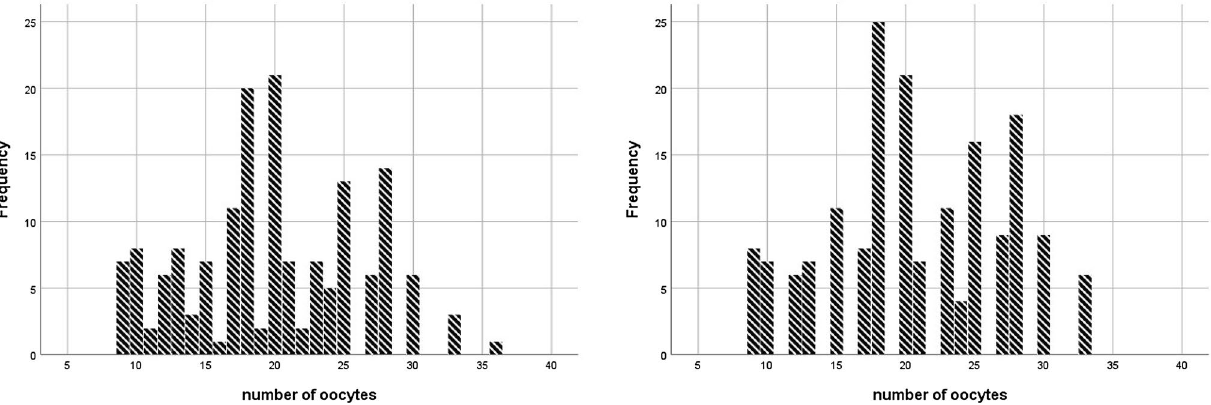
Figure 1. Frequency distribution of number of oocytes retrieved in the two protocols.